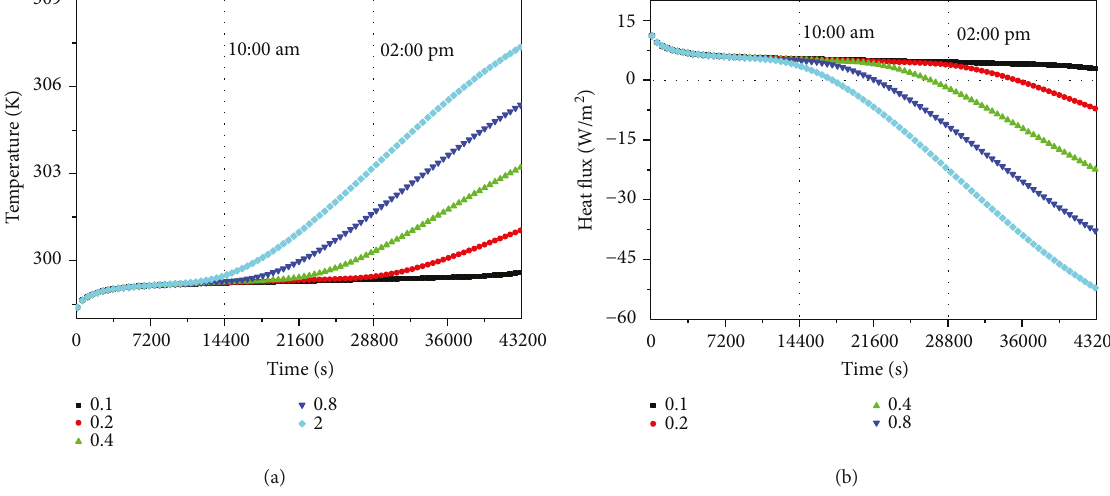
Figure 8: Temperature variation and heat fl ux of the inside wall for case 2 under di ff erent thermal conductivities of